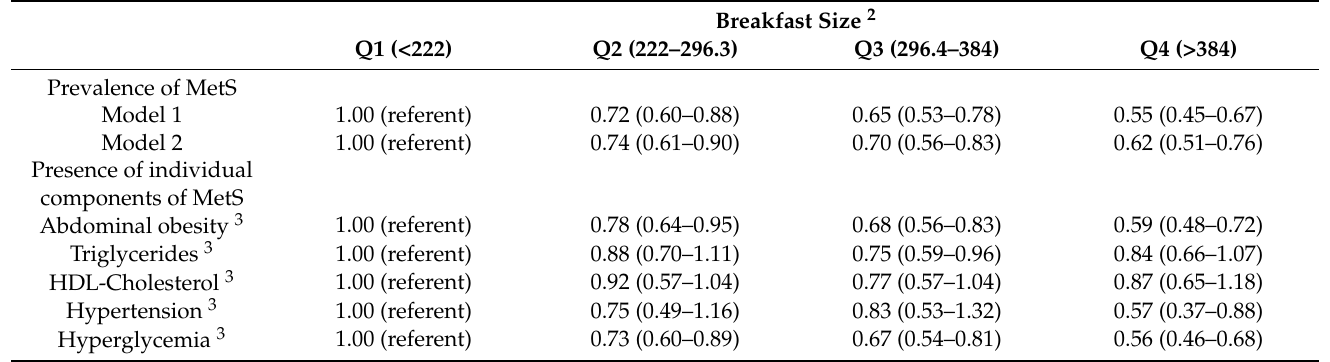
Table 3. Association (OR, 95% CI) between energy contribution from breakfast and prevalence of Metabolic Syndrome 1 and for each individual